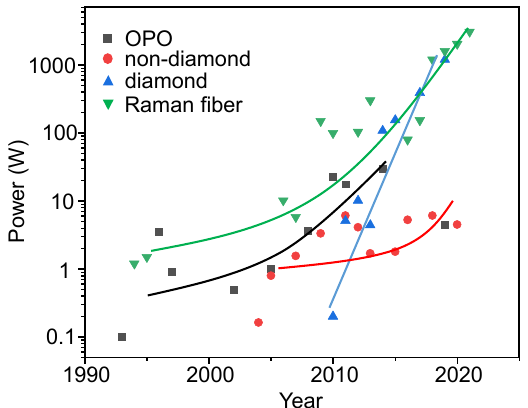
Figure 5. Evolution of the output power of CW nonlinear lasers over the past 30 years. Solid line denotes the power trend over the years.